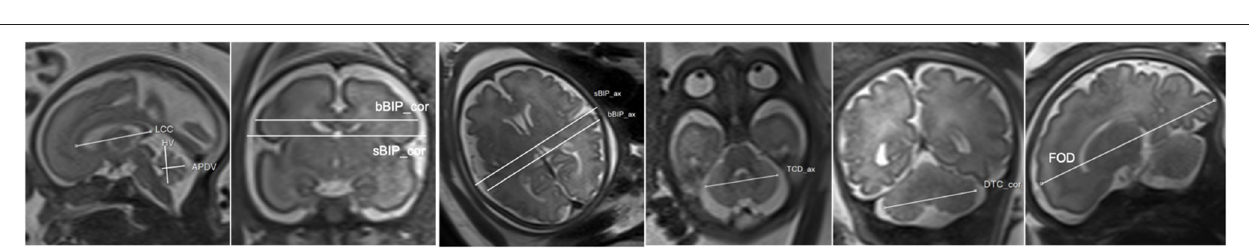
FIGURE 3 | Biometric measurements. LCC, length of the corpus callosum; APDV, anteroposterior diameter of the vermis; HV, height of the vermis; bBIP_cor, sBIP_cor, bBIP_ax, sBIP_ax, brain and skull biparietal diameter (coronal and axial); TCD_ax and TCD_cor, transverse cerebellar diameter (axial and coronal); FOD, fronto-occipital